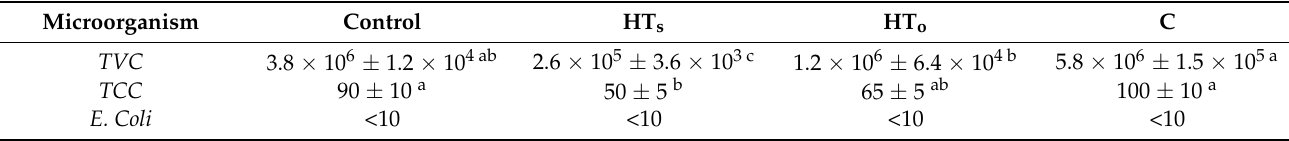
Table 6. Microbiological content (cfu/g) of fuet samples at day 21 of refrigerated storage in aerobic conditions. Microorganism